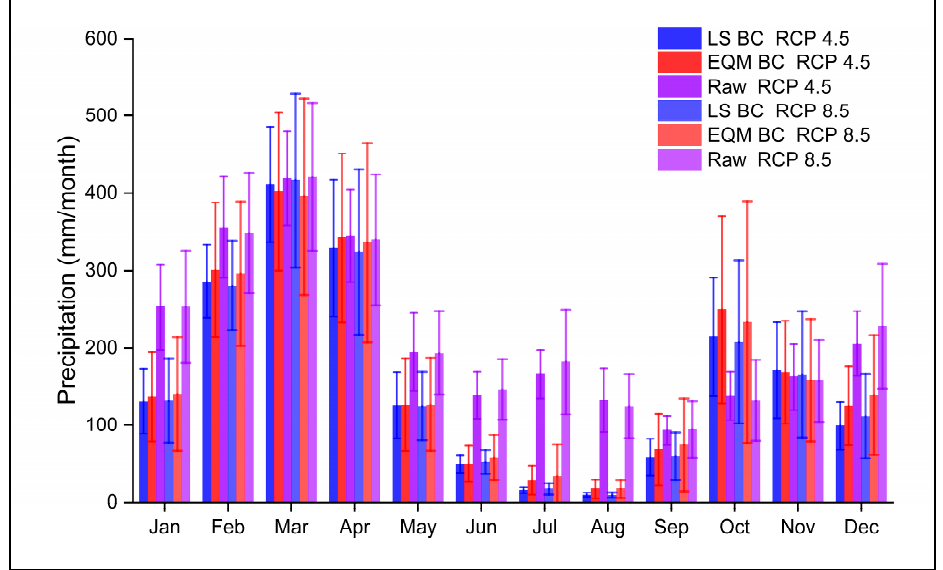
Figure 5. Mean monthly precipitation, as provided by the ensemble mean of the 21 NEX-GDDP models when they are LS-corrected (LS BC), EQM-corrected (EQM BC), and when their raw outputs (Raw) are considered. The error bars represent the standard deviation across the 21 models for the period 2040–2069. Likewise, for the case of temperature (Figure 6), the LS and EQM methods were also shown to similarly modify the signal projected by raw NEX-GDDP models. Particularly, both approaches correct the cold values exhibited by the raw NEX-GDDP models, which are far from the observed regime throughout the year (Figure 3).